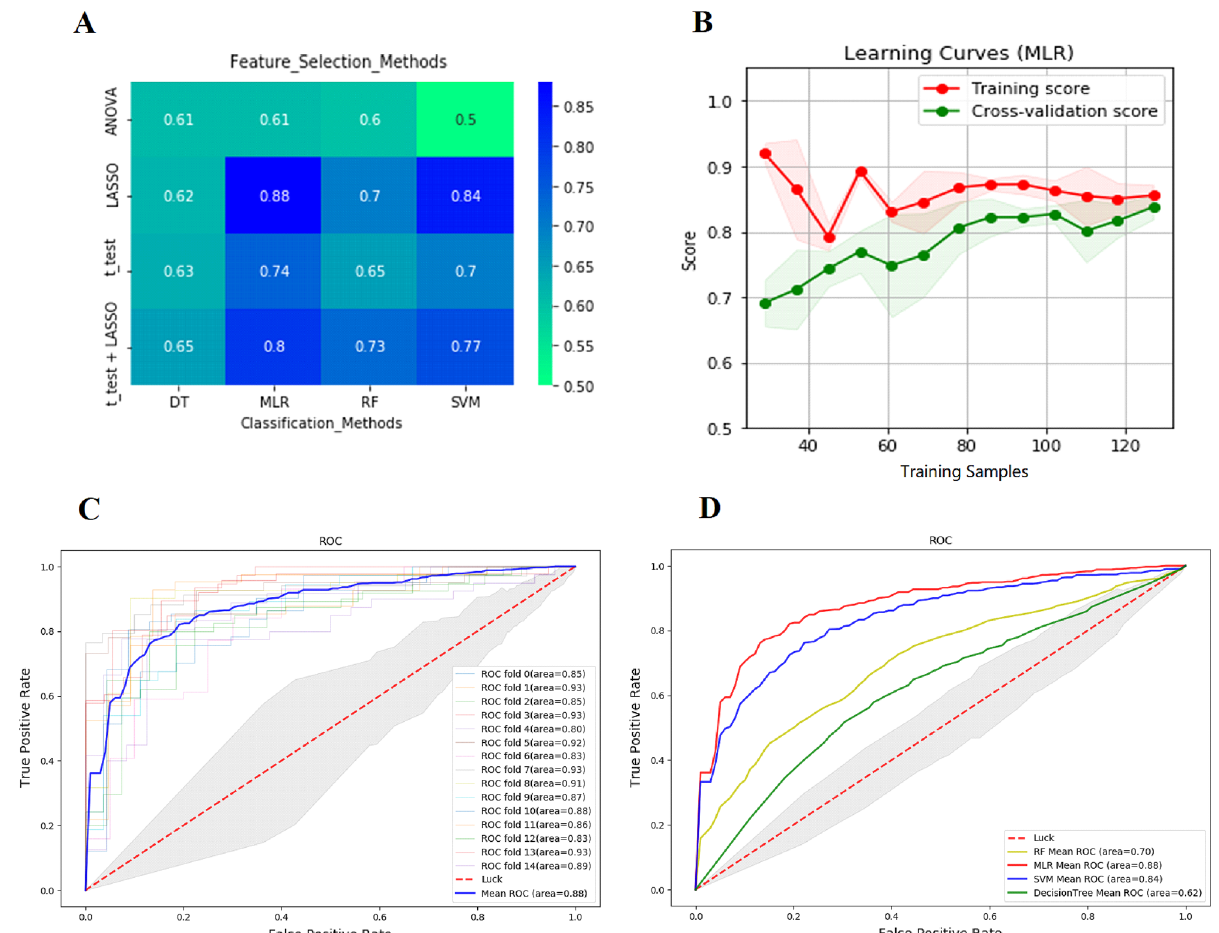
Figure 3. The building of machine-learning models. ( A ) Heatmap of AUC for different feature selection methods and classifier combinations. ( B ) Learning curve of the best combination (LASSO + MLR). ( C ) ROC curves for each of the 15 validations of the LASSO + MLR combination and the average ROC curve for all validation results. ( D ) ROC curves for combinations of LASSO and different classifier.